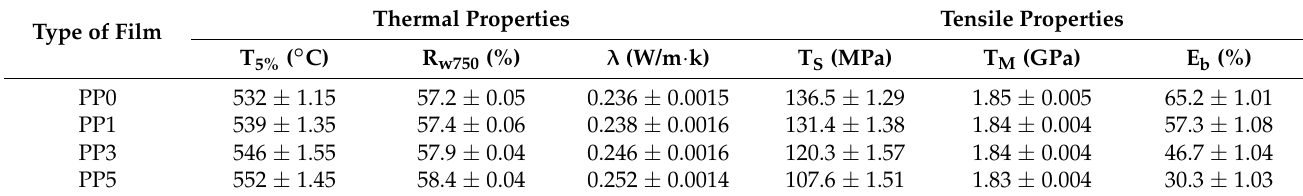
Table 2. Thermal and mechanical properties of POSS–polyimide composite films.